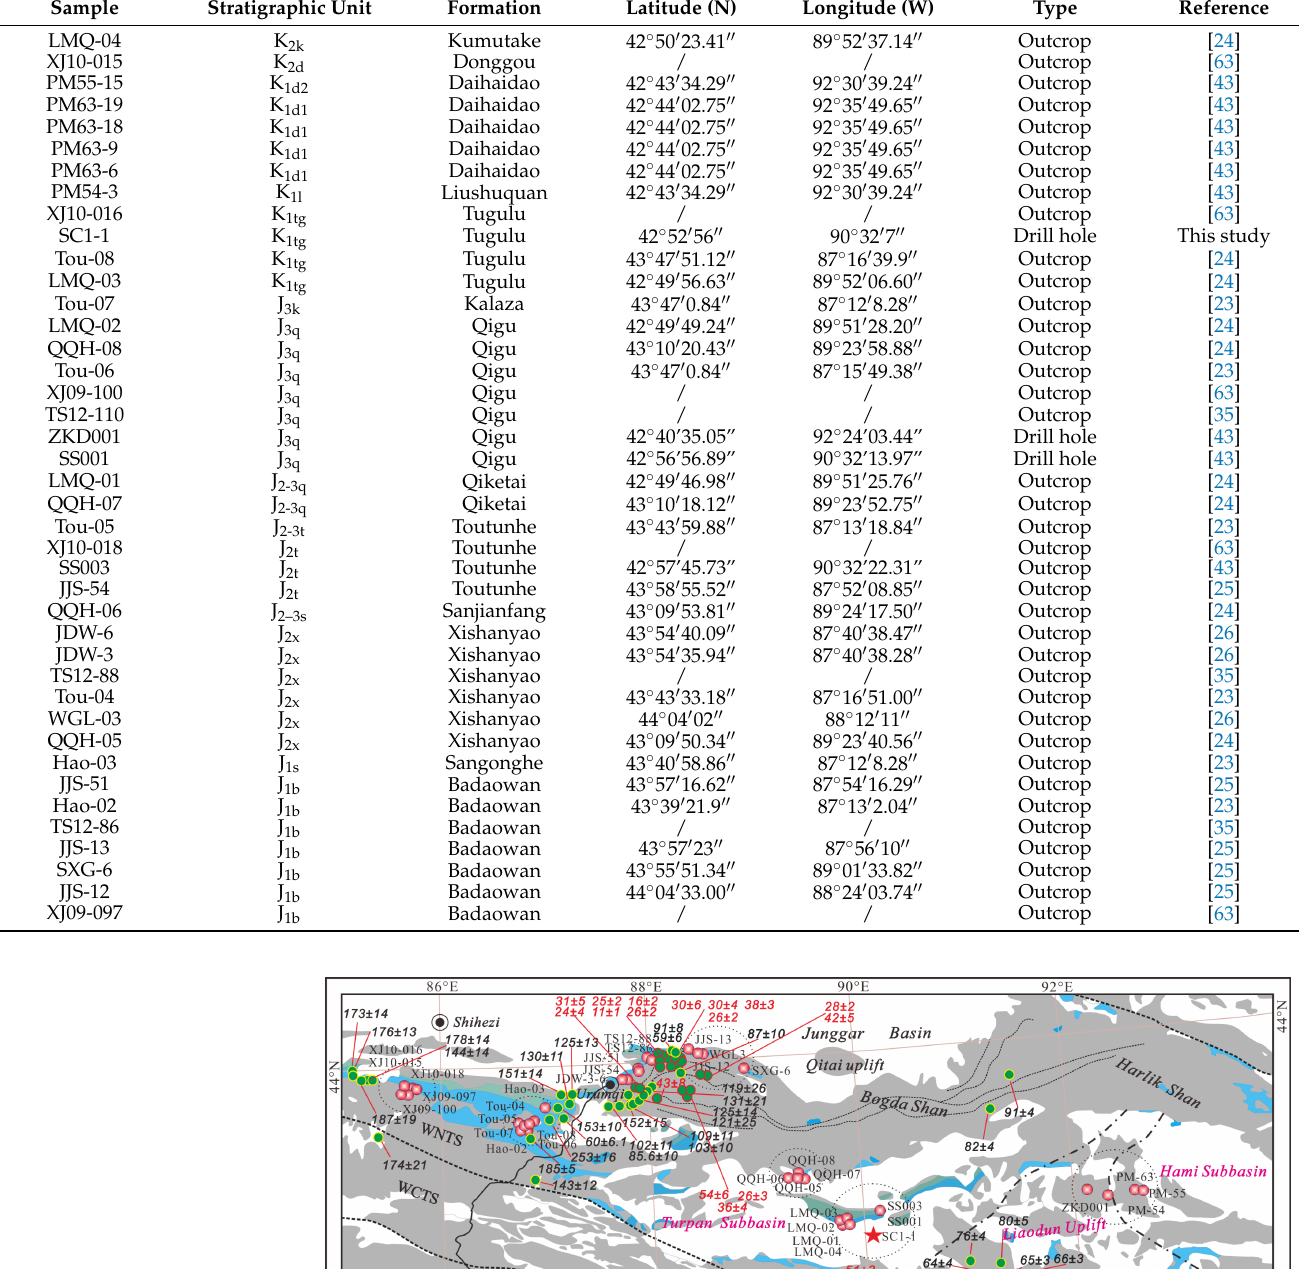
Table 1. Summary of samples statistics (data from [23–26,33,35,43,63] and this study). See Figures 1c and 3 for details of the locations.